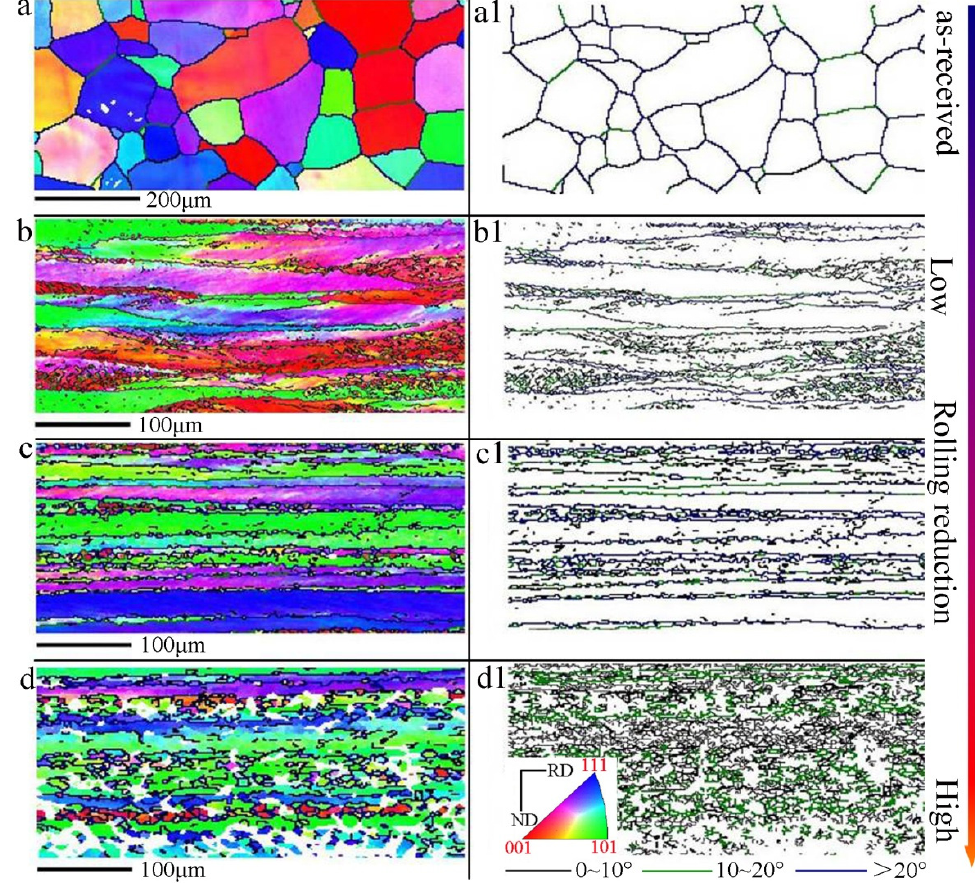
Figure 3. Orientation image microscope and boundary structure with different cold reductions of ( a , a1 ) as-received; ( b , b1 ) CR-70%; ( c , c1 ) CR-85%; ( d , d1 ) CR-98%.